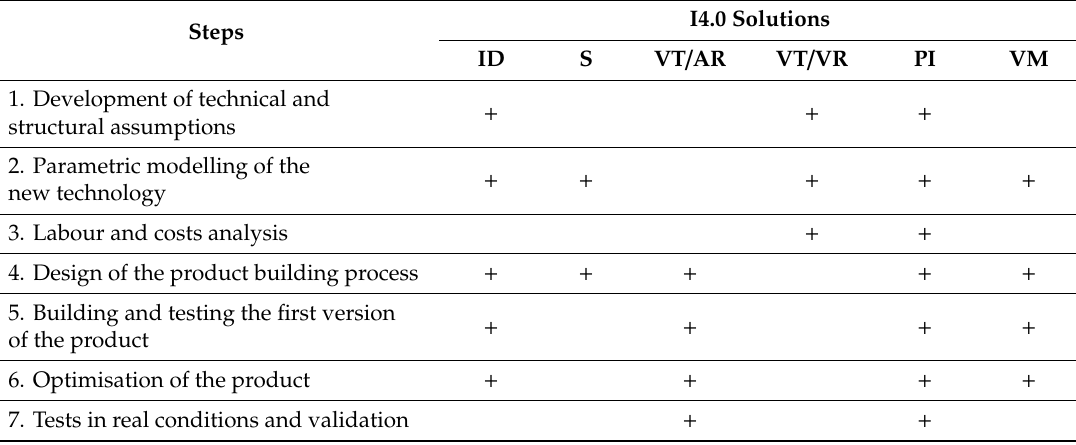
Table 1. Industry 4.0 (I4.0) solutions that may provide benefits at particular steps of the PDP.